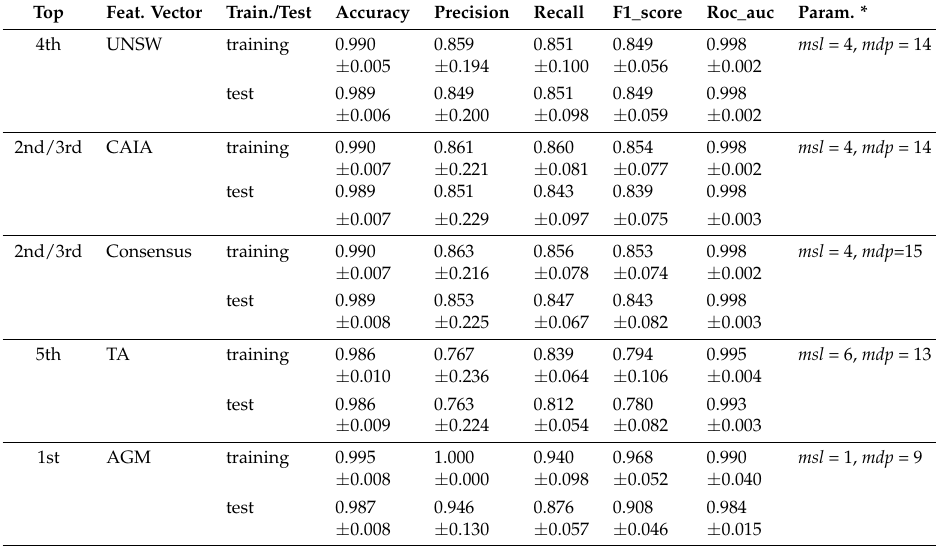
Table 5. Classification results with Random